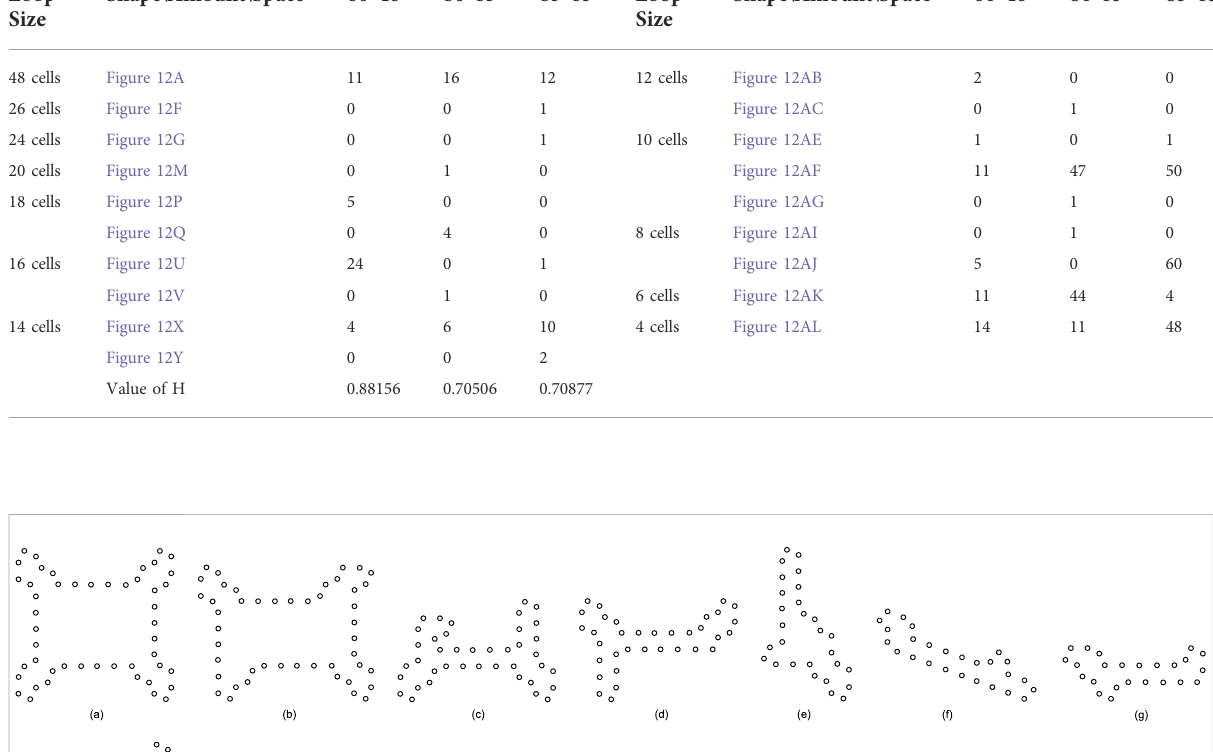
TABLE 16 Statistical numbers of the loops with various structures for the changing mechanism on different cellular spaces starting from the initial con fi guration in Figure 7E. Loop Size